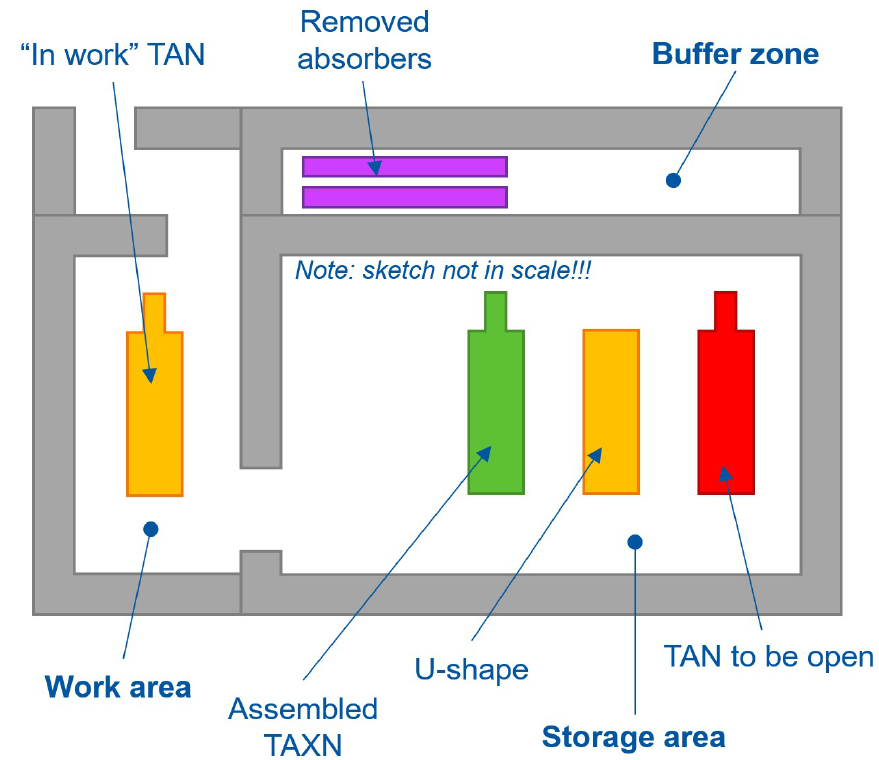
Figure 6. Possible worksite layout, based on the preliminary estimates from FLUKA-SESAME simulations (for illustration purposes only, sketch not in